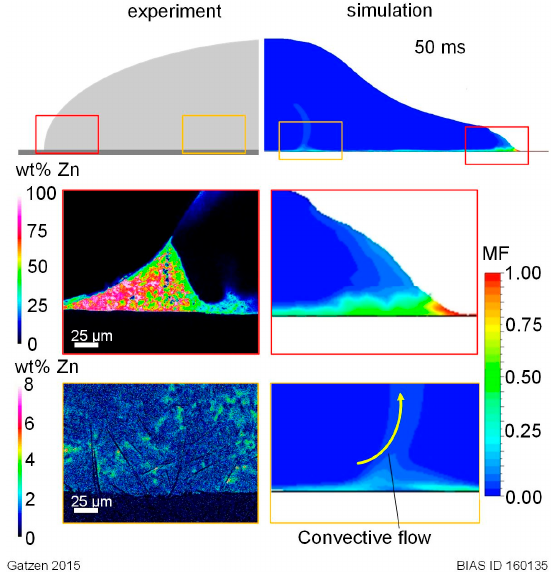
Figure 5. Simulated zinc distribution (mass fraction, MF ) near the weld toe that is already solidified and near the middle of the droplet that is still liquid compared to WDS (wavelength-dispersive X-ray spectroscopy) scans of the same zones on the cross-sections of the completely solidified droplet from the wetting